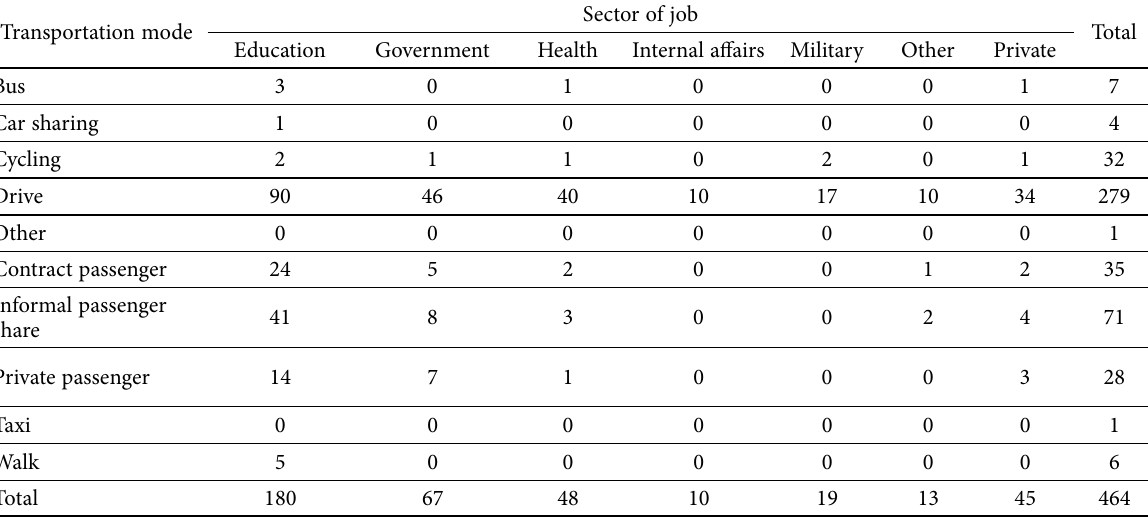
Table 3. Cross tabulation of mode chosen and sector of